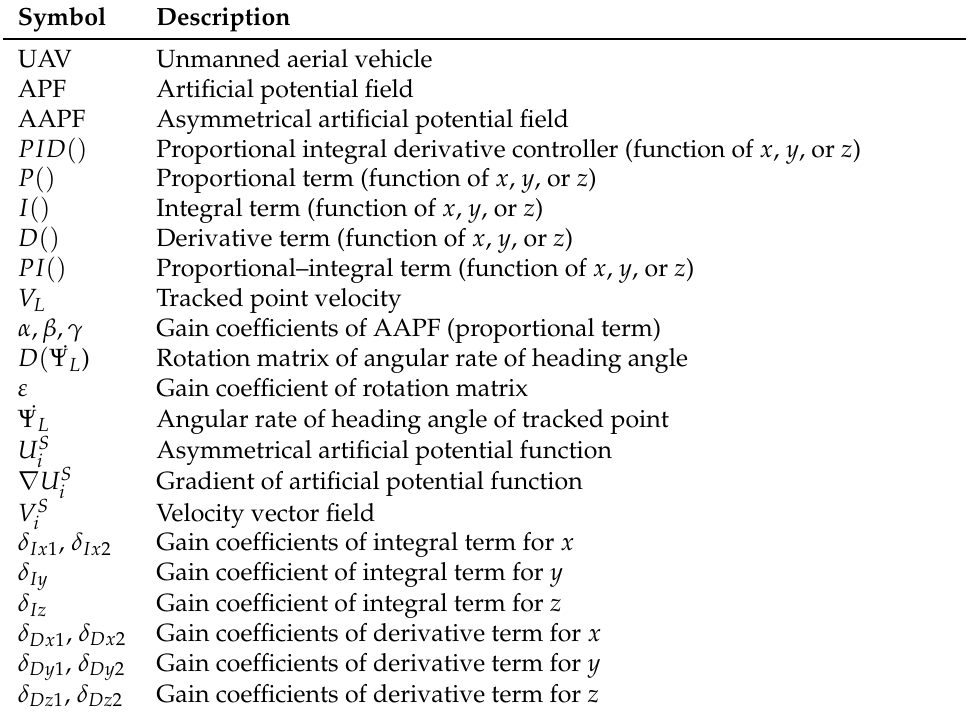
Table 1. List of symbols and